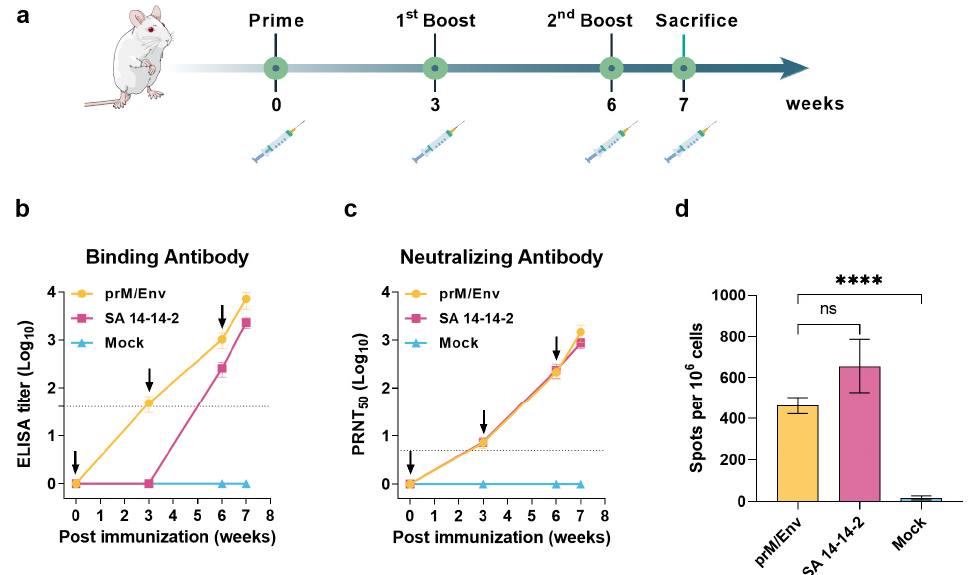
Figure 2. JEV VLP induced robust humoral and T cell immune responses in BALB/c mice. ( a ) Flow chart of JEV VLP immunogenicity evaluation in mice model. Solid vertical lines indicate weeks of immunization (black), sacrifice (green), and syringe symbols indicate blood sampling time points. ( b ) JEV specific binding antibodies were assessed by ELISA. Dotted lines indicate detection limit. ( c ) Neutralizing antibodies against JEV SA 14-14-2 strain were measured by PRNT assay. Dotted lines indicate detection limit. ( d ) Spleens and splenocytes were collected at weeks 7 for IFN- γ detection by ELISPOT after stimulation with JEV Env peptide pools. Data are shown as means ± SEM (standard errors of means). p values were analyzed by Student’s t -test (ns, p > 0.05; ****, p <